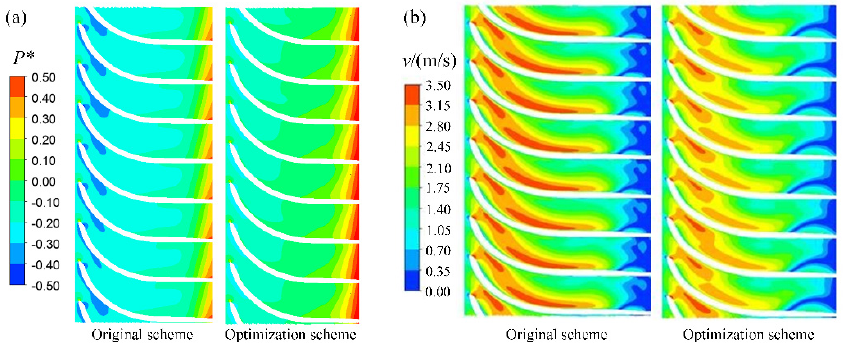
Figure 18. Time-averaged pressure coefficient distribution curve from inlet to outlet of compound impeller before and after optimization under the rated condition. Figure 19. Time-averaged pressure coefficient distribution at 0.8 times blade height ( a ) and time-averaged velocity distribution at 0.5 times blade height ( b ) in impeller passage before and after optimization.